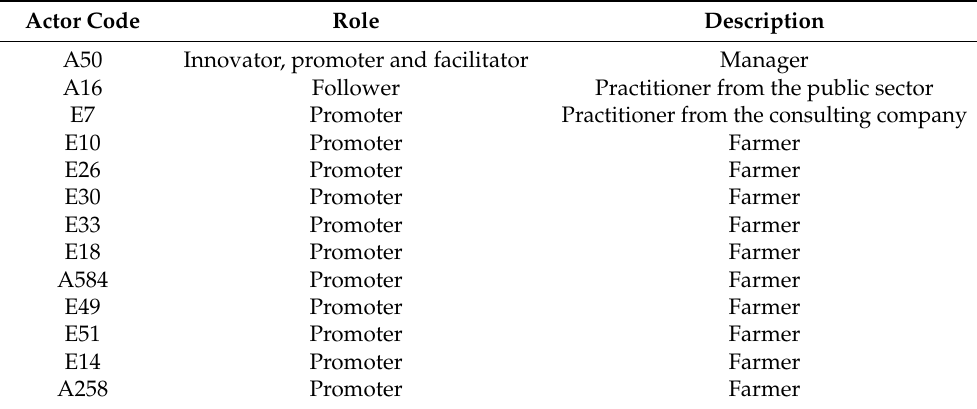
Table 3. Key actors examined in the Social Network Analysis. Own elaboration.